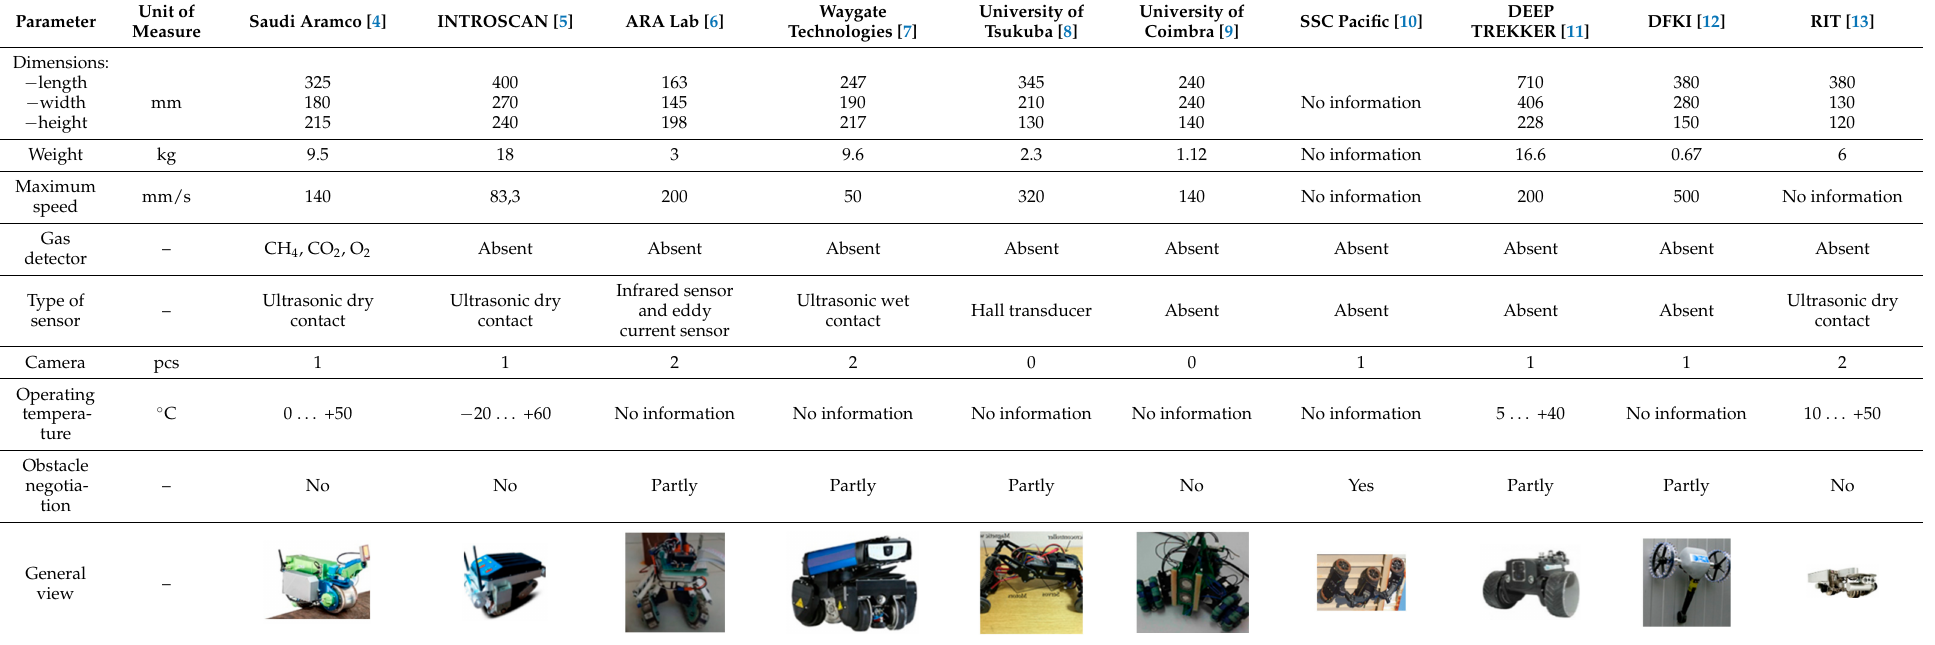
Table 2. Technical characteristics of robotic